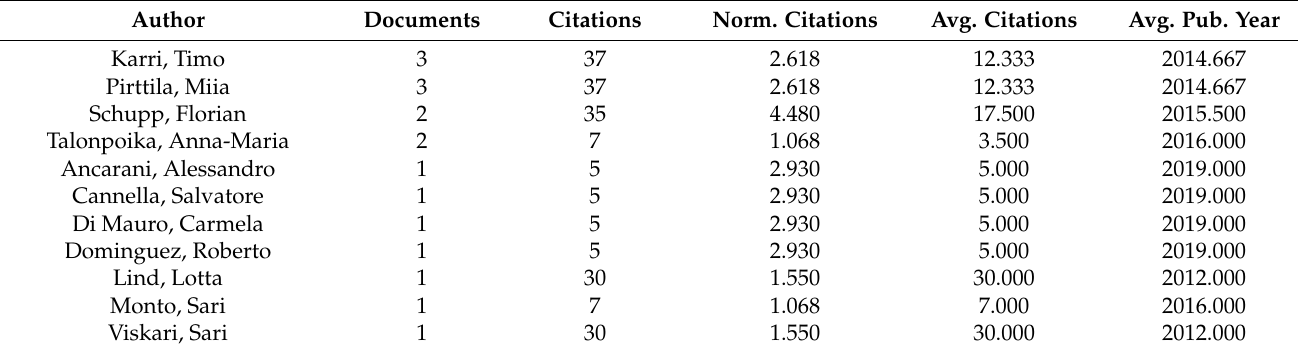
Table 3. Co-authorship links and authors items, considering 1 as the minimum number of documents from an author.